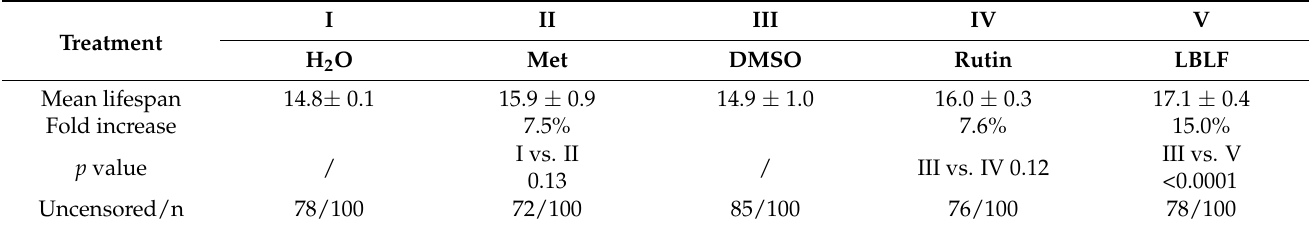
Figure 6. Effect of LBLF on the lifespan, motility scoring statistics and mRNA level of C. elegans . Effect of LBLF on the lifespan of C. elegans ( A ). Effect of LBLF on the motility scoring statistics of C. elegans ( B ). Effect of LBLF on the mRNA expression levels of related redox-modulation and anti-aging genes in C. elegans ( C ). Motion level was divided into three levels: if the worm moved spontaneously and smoothly, it was marked as “A”, if the worm moved in a non-sinusoidal trajectory after stimulation, it was marked as “B”, if the animal did not move forward but could respond to touch by swinging its head or tail, it was marked as “C”. Rut (100 μM rutin), met (50 mM metformin) and LBLF (200 µg/mL LBLF). At least 3000 worms were used in each group and the experiments were independently performed three times. The different letters in the column indicated significant differences in values ( p < 0.05). * in the Figure represents extremely significant differences in expression levels at different stages ( p < 0.05). Lowercase letters ns in the Figure represent unsignificant differences in expression levels at different stages ( p > 0.05). Table 4. Statistical analysis of C. elegans lifespan.